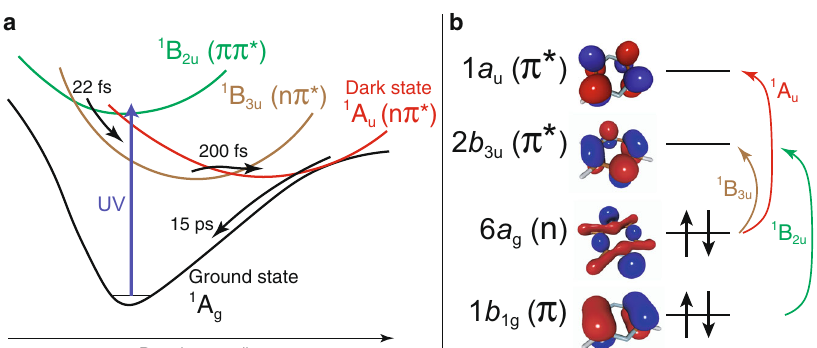
Fig. 1 Potential energy surfaces and molecular orbitals of pyrazine. a Upon absorption of an ultraviolet photon (blue vertical arrow) energy fl ows through the 1 B 2u (green), 1 B 3u (brown), and 1 A u (red) states; timescales in the sequence 1 B 2u → 1 B 3u → 1 Α u → 1 Α g are represented with curved arrows. b Arrows represent dominant transition characters of the valence excited states, relevant molecular orbitals are shown with their irreducible representations of the D 2h point group. Supplementary Table 1 provides the analysis in terms of natural transition orbitals